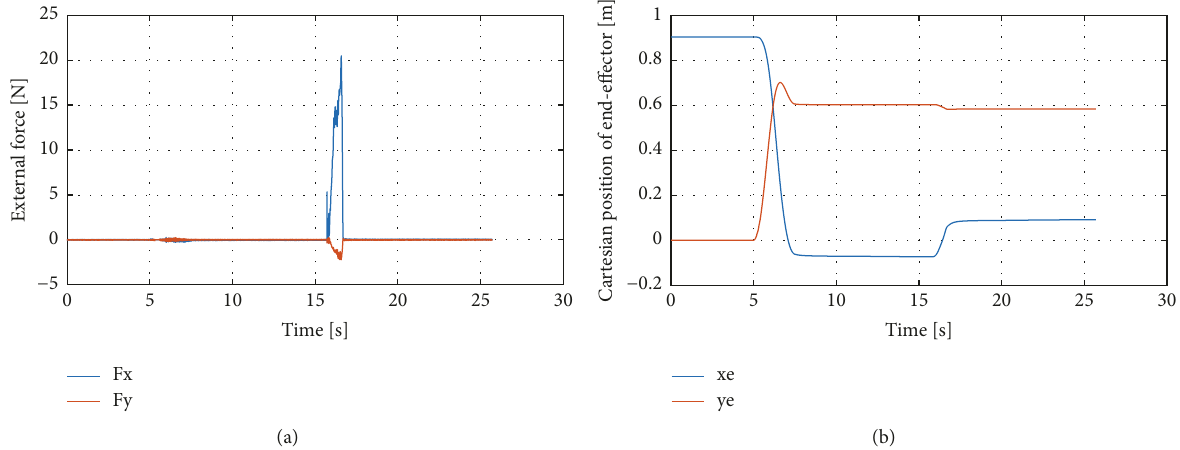
Figure 6: Experimental results of Maxwell model based Cartesian impedance control. (a) External force. (b) End-effector position in Cartesian space.